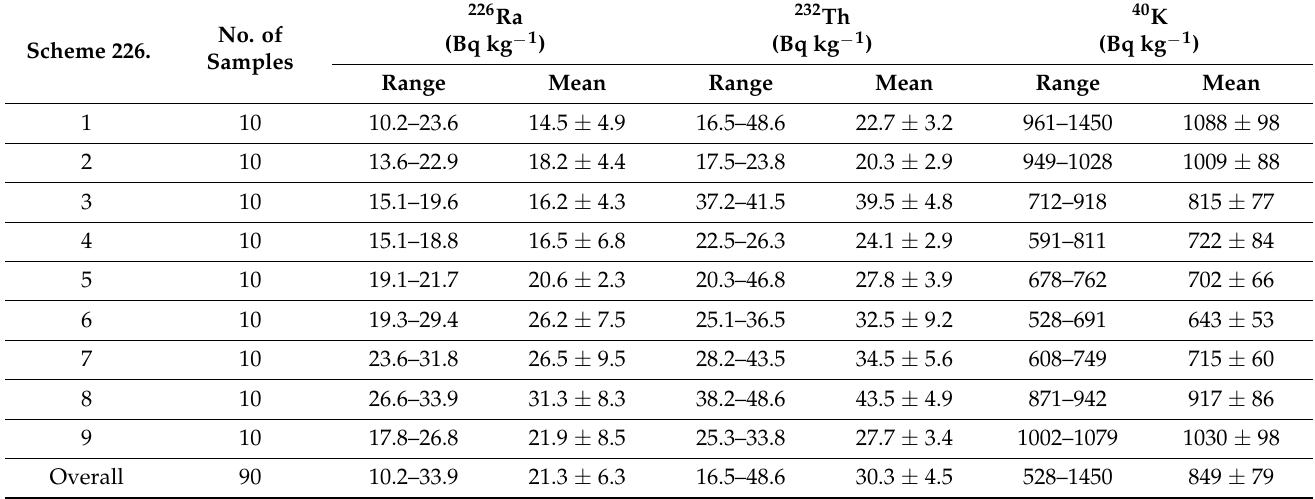
Table 2. Activity concentrations of 226 Ra, 232 Th and 40 K in the investigated sampling sites.